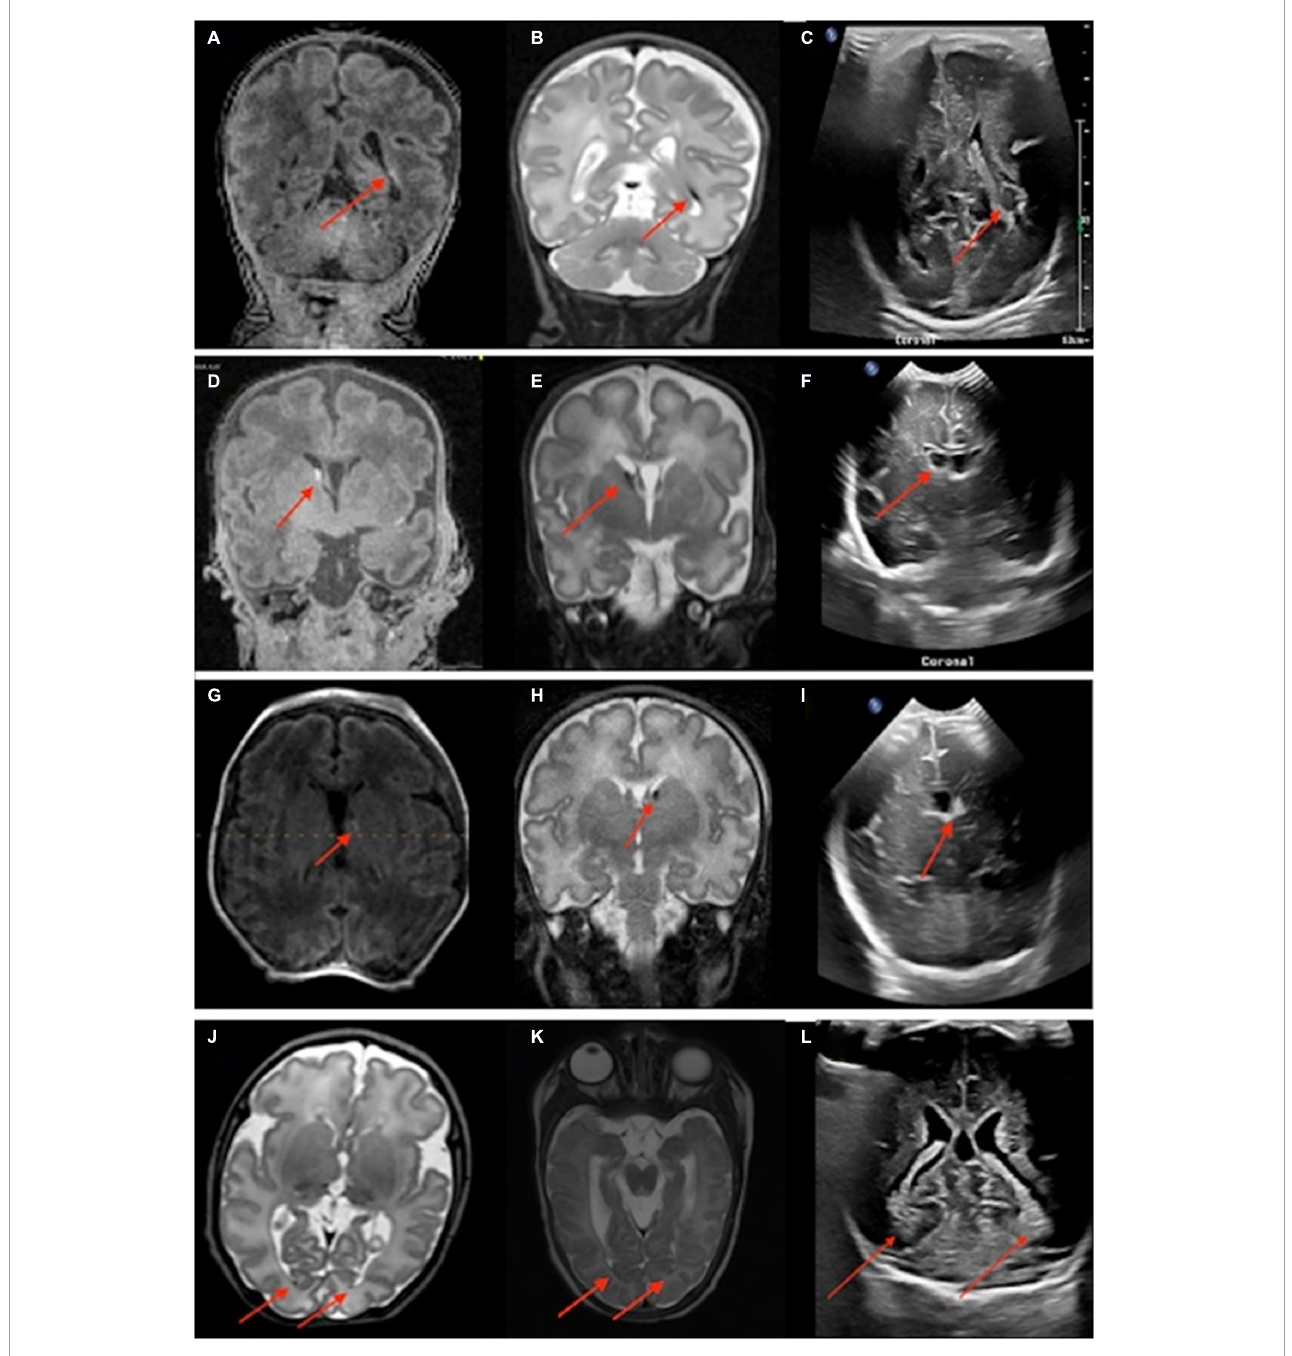
FIGURE3 Neonates scanned on point-of-care 1-Tesla MRI for intraventricular hemorrhage (IVH) follow-up. An 80-day-old infant with T1 hyperintense (A) and T2 hypointense (B) grade II left germinal matrix hemorrhage on point-of-care 1-Tesla MRI performed 70 days after transcranial ultrasound (C) . A 52-day-old infant with T1 hyperintense (D) and T2 hypointense (E) right-sided grade I germinal matrix hemorrhage on point-of-care 1-Tesla MRI performed 34 days after transcranial ultrasound (F) . A 28-day-old infant with T1 hyperintense (G) and T2 hypointense (H) left-sided grade I germinal matrix hemorrhage on point-of-care 1-Tesla MRI performed 15 days after transcranial ultrasound (I) . An 85-day-old infant with layering T2 hypointense IVH (J) on point-of-care 1-Tesla MRI, which was also visualized on follow-up 3-Tesla MRI 38 days later (K) and was sequela of grade 2 IVH seen on transcranial ultrasound performed 74 days earlier (L)